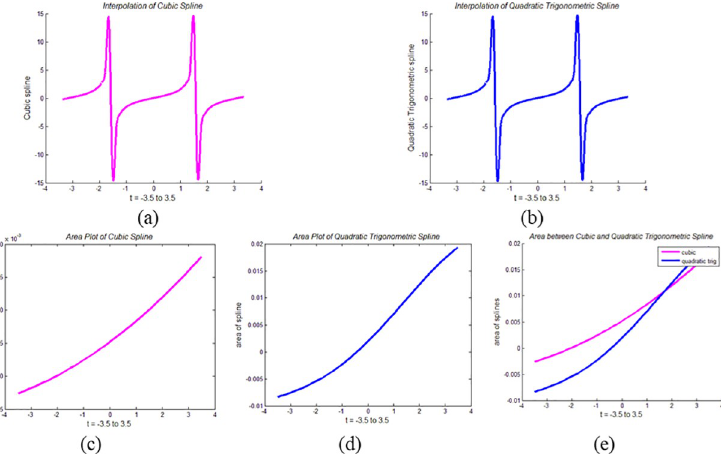
Fig 6. Area Analysis of QTS and CPS using f = tan( t ): (a) Plot of CPS, (b) Plot of QTS, (c) Area plot of CPS, (d) Area plot of QTS, and (e) Area between CPS and QTS.